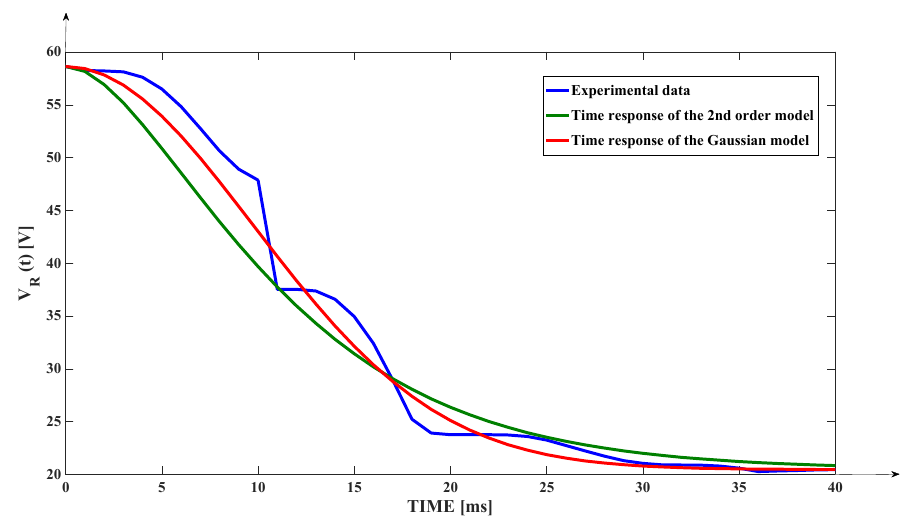
Figure 7. Comparison between the two types of proposed models.